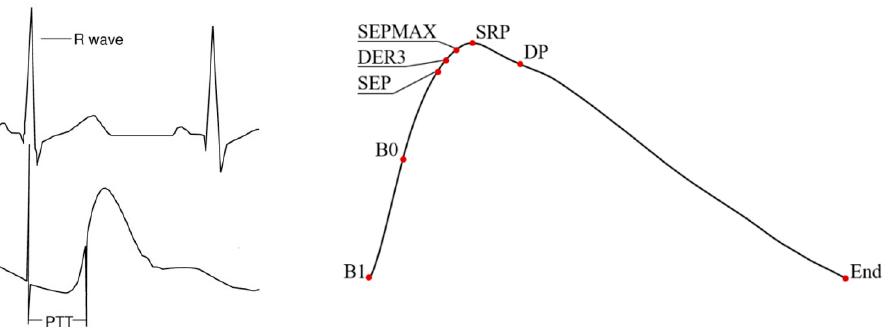
Figure 3. Pulse transit time and pulse wave acquired by photoplethysmography with points of interest. B1 = beginning of the pulse wave, B0 = point of maximum increase of the anterior leg, SEP = peak of the ejection pulse wave, DER3 = first positive peak of the 3th derivate, SEPMAX = first inflection of the pulse wave, SRP = peak of the reflected systolic wave, DP = peak of the diastolic wave, End = end of the pulse wave.